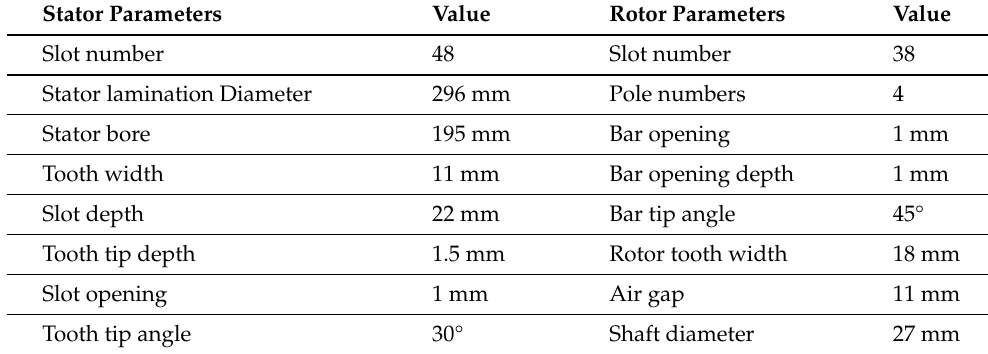
Table 1. Stator and Rotor Parameters.